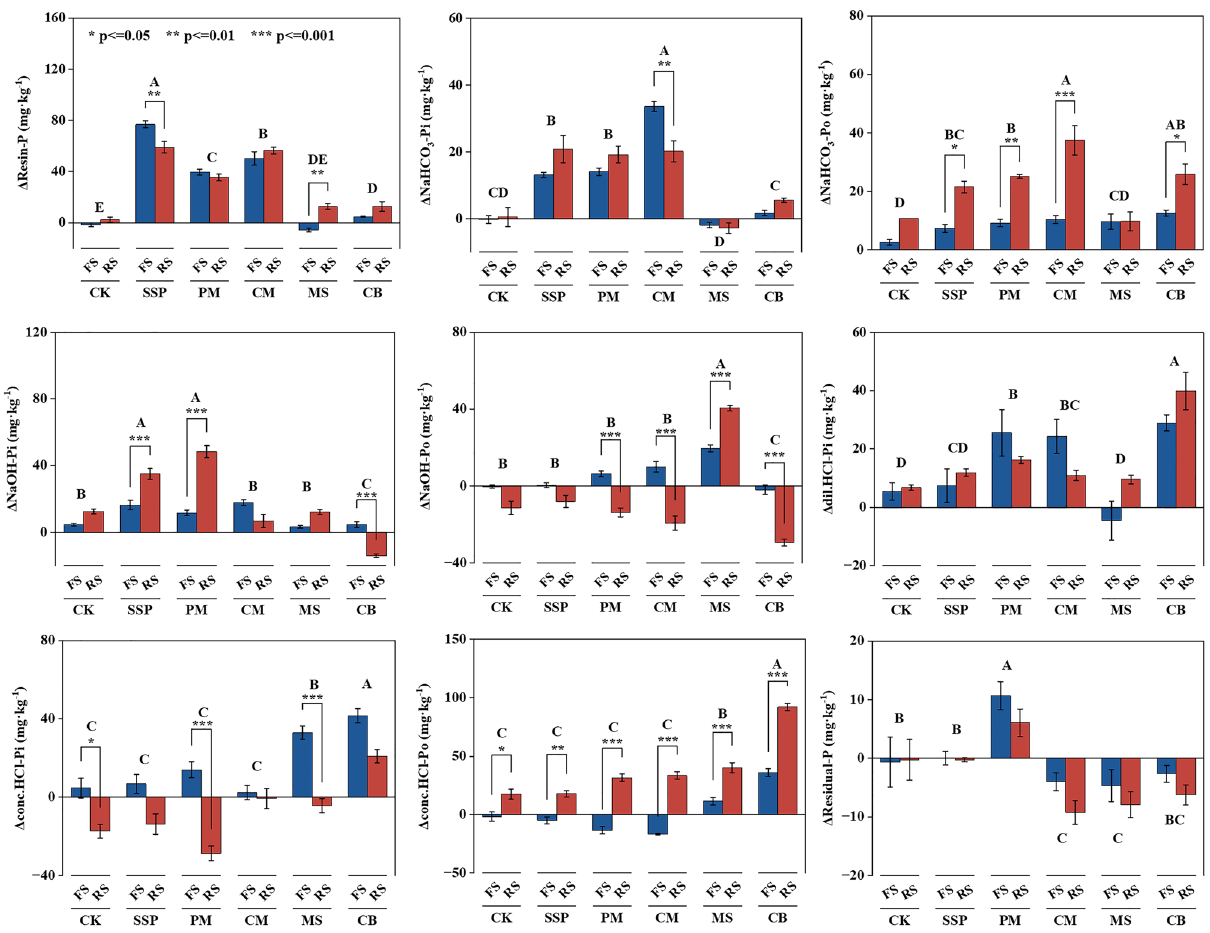
Figure 2. Changes in P fractions (ΔP fractions) in fluvo-aquic and red soils amended with different phosphorus sources on DAI 70. Values are means ± SE (n = 4). FS: Fluvo-aquic soils; RS: Red soils; CK: Control; SSP: Ca(H 2 PO 4 ) 2 ; PM: Poultry Manure; CM: Cattle Manure; MS: Maize Straw; CB: Cattle Bone Meal. Dissimilar uppercase letters denote significant differences among the P sources ( P < 0.05). * indicate significant differences between the fluvo-aquic soil and red soil. *, ** and *** indicate significant at P < 0.05, P < 0.01 and P < 0.001, respectively. The error bar represents